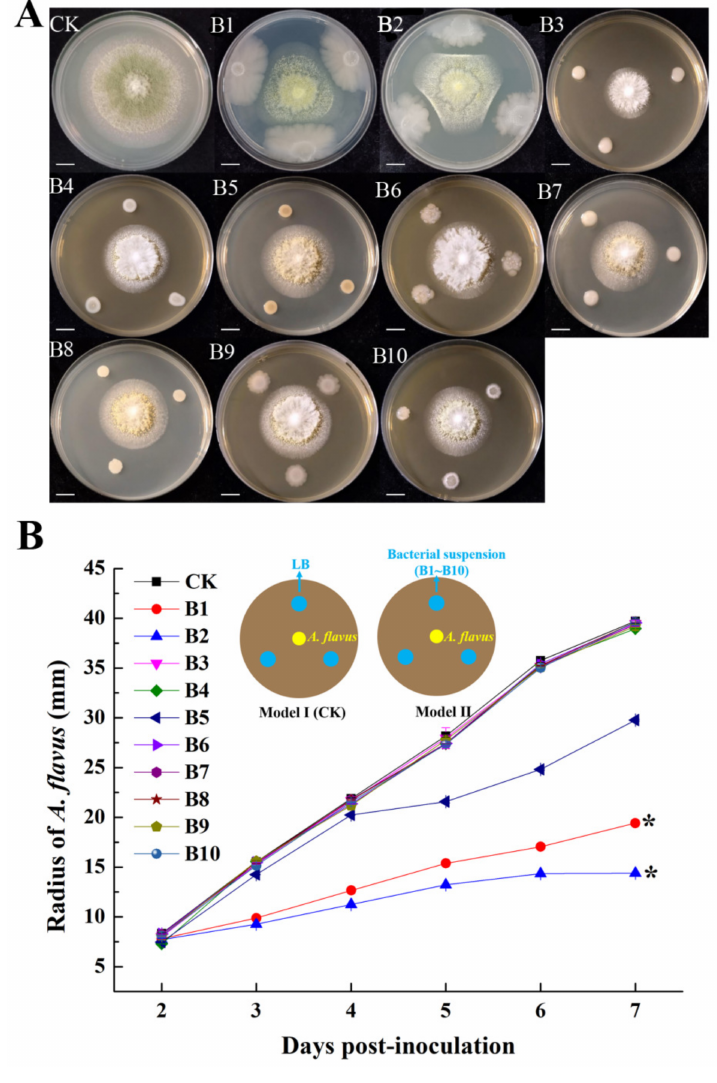
Figure 1. Inhibitory effect of bacterial isolates against A. flavus . ( A ) Plate confrontation antagonism test and colony pictures were taken at four days post-inoculation. Scale bars represent 10 mm. ( B ) Growth of A. flavus when A. flavus only (CK) and inhibited by different bacterial isolates such as B1, B2, B3, B4, B5, B6, B7, B8, B9 and B10. The star (*) indicates that the growth of A. flavus